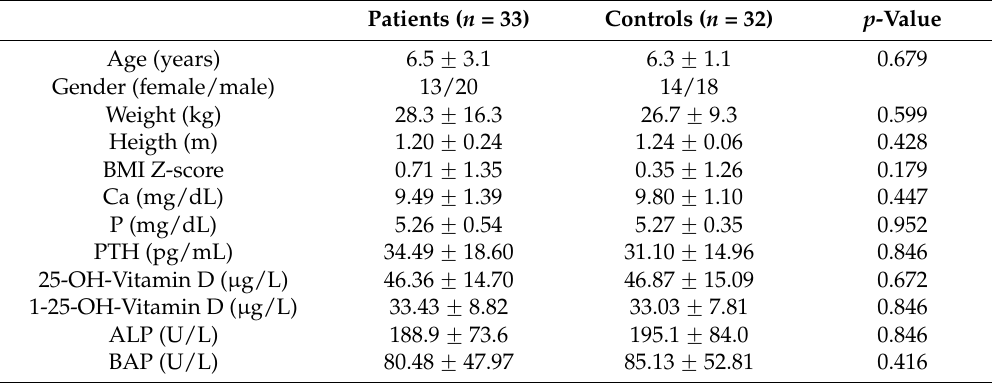
Table 1. Demographics and laboratory of patients and control